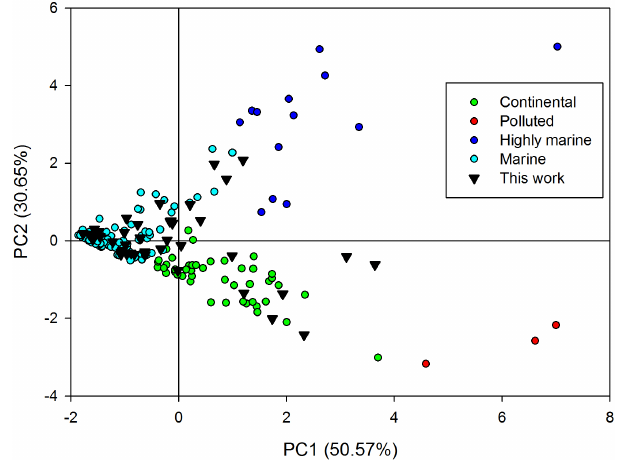
Figure 2. Scores plot obtained by PCA analysis of 137 sam- ples (corresponding to 73 cloud events) collected before 2013 and grouped in four classes in function of the previously described clas- sification (Deguillaume et al., 2014) and 41 samples (numbered from 80 to 120) collected during 2013 and 2014. These new data correspond to 15 cloud events and are indicated in black triangles. Statistical analysis is performed using six selected variables (pH, [Na + ], [Cl − ], [SO 2 − ], [NO − ], and [NH + ]). The scree plot ob- 4 3 4 tained from autoscaled data shows two selected principal compo- nents (PCs) containing a total variance of about